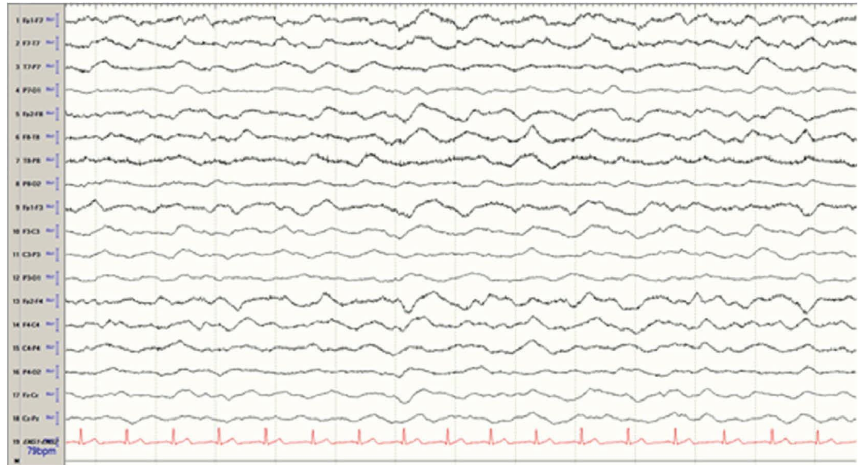
Figure 2: Continuous electroencephalography (CEEG) showing a continuous delta slowing maximum in the bifrontal regions captured before the onset of choreiform movements. Te patient was not on any continuous sedation during this period that would alter their level of consciousness. No seizure activity noted. (Bipolar montage; LF 1.6 Hz, HF 70 Hz, sensitivity 7uV; 15s